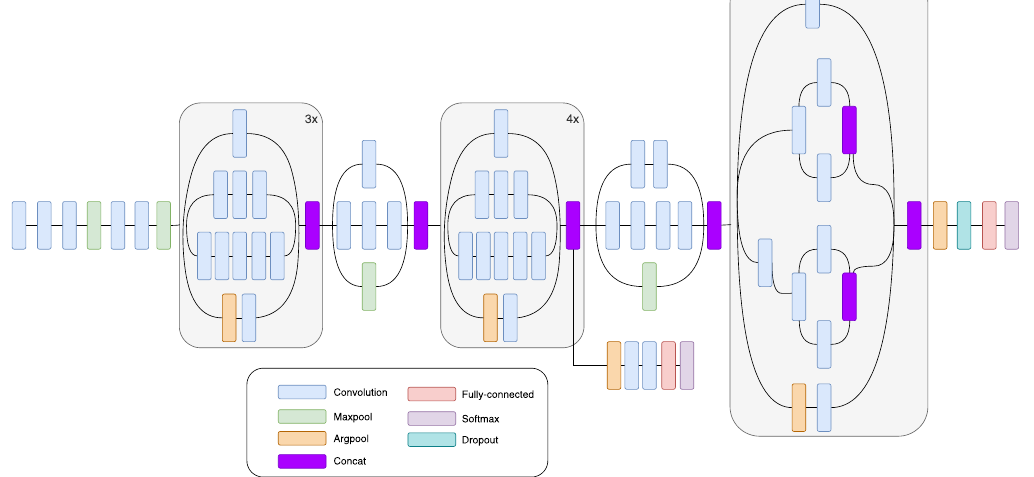
Figure 2. Schematic drawing of the InceptionV3 convolutional neural network (CNN) [51].